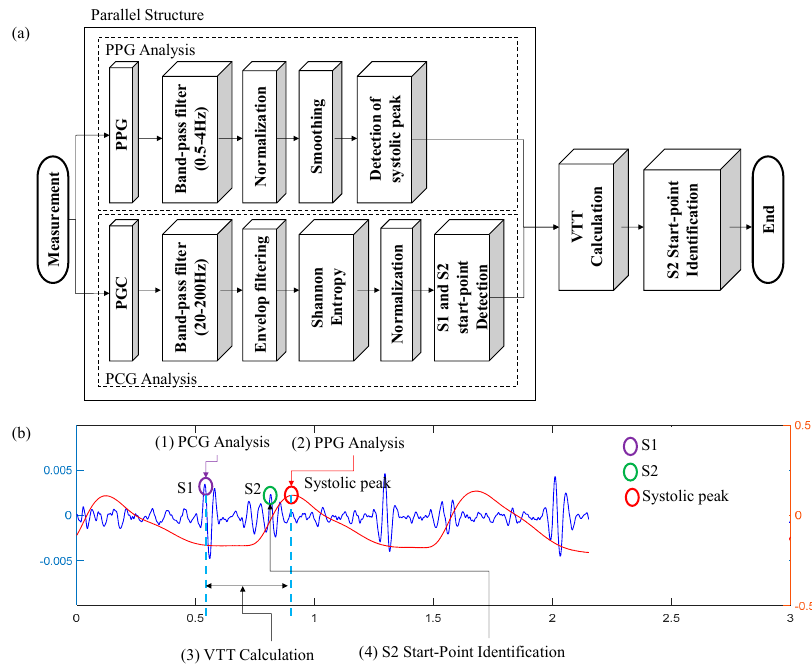
Figure 5. The proposed method of DDM-HSA for daily life monitoring: ( a ) flowchart ( b ) processing example (blue-solid line: PCG; red-solid line: PPG).